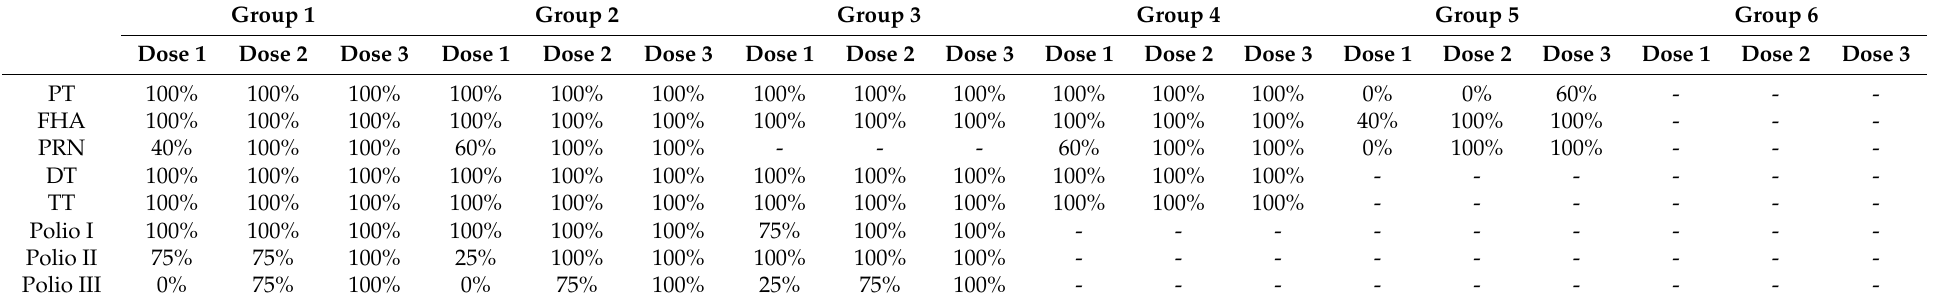
Table 2. Seroconversion rates (%) against different components of the combined vaccines after each dose of immunization. Group